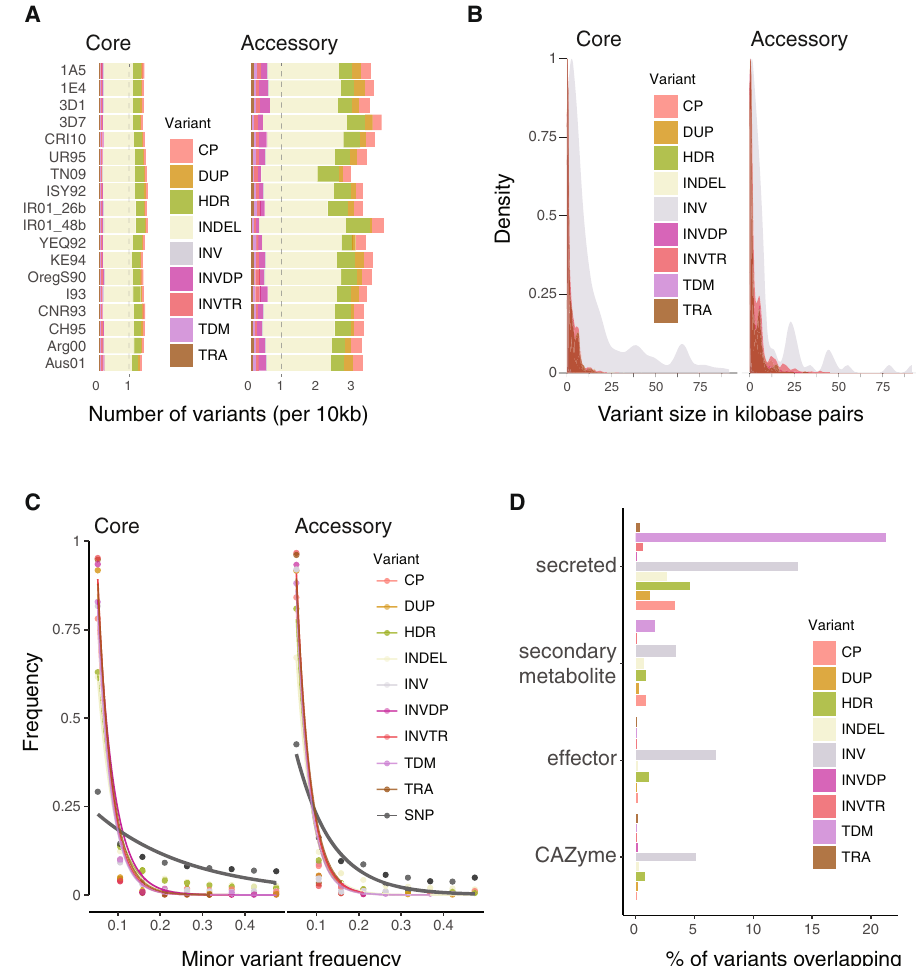
Fig. 2 Structural variant heterogeneity across chromosomes and associations with genes. A Whole-genome alignment-based structural variants per 10 kilobase pairs (kb) among isolates. Copy polymorphisms (CP), duplications (DUP), highly diverged regions (HDR), indels (INDEL), inversions (INV), inverted duplications (INVDP), inverted translocations (INVTR), tandem repeats (TDM), and translocations (TRA). B Size distribution of the nine structural variant types. C Minor allele frequency distribution. Curves show estimates of the exponential decay calculated for each variant type. D Proportion of each type of variant overlapping with different gene category playing a role in fungal pathogenesis including secondary metabolite clusters, genes encoding for predicted secreted proteins, effectors, and carbohydrate-active enzymes